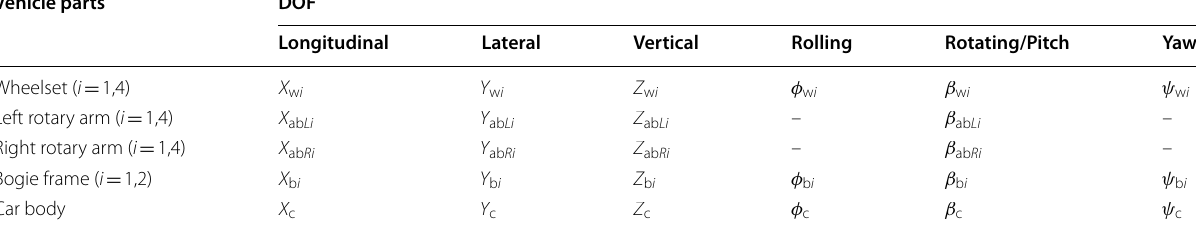
Table 1 Subway Vehicle System DOF Vehicle